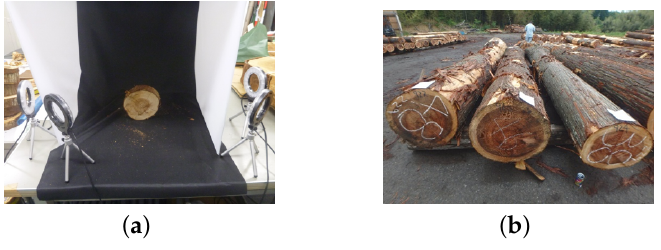
Figure 6. The environment for acquiring images. ( a ) The indoor environment for acquiring images. ( b ) The outdoor environment for acquiring